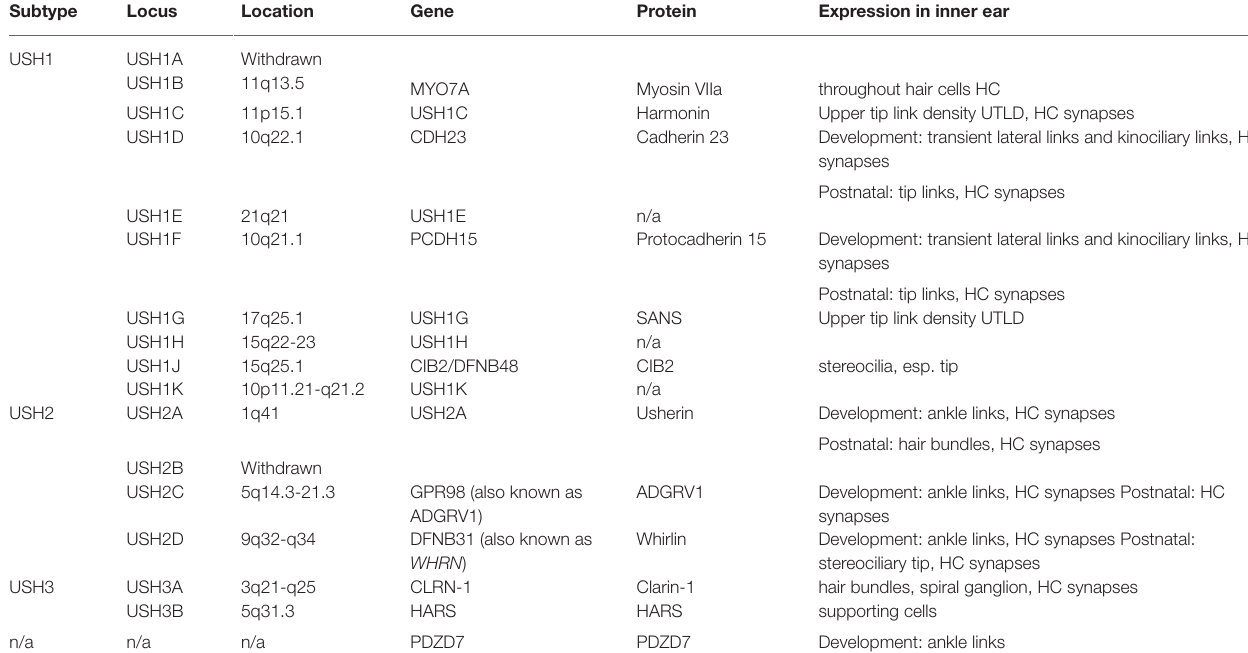
TABLE 1 | The subtypes of USH and their known associated genes and proteins. Subtype